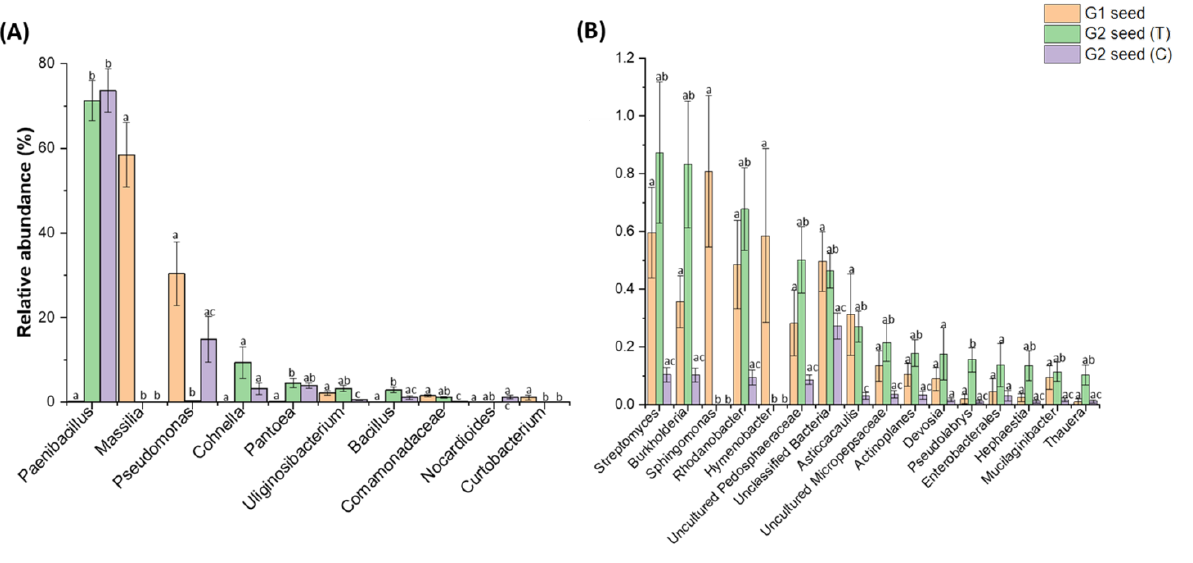
Figure 4. Significant differences ( p ≤ 0.05) among the bacterial genera with relative abundance ( A ) >1% and ( B ) <1%, >0.1%. between G. clandestina seed (G1) and G2 (T and C) seed. The comparisons were determined by using one-way ANOVA followed by Tukey's test.